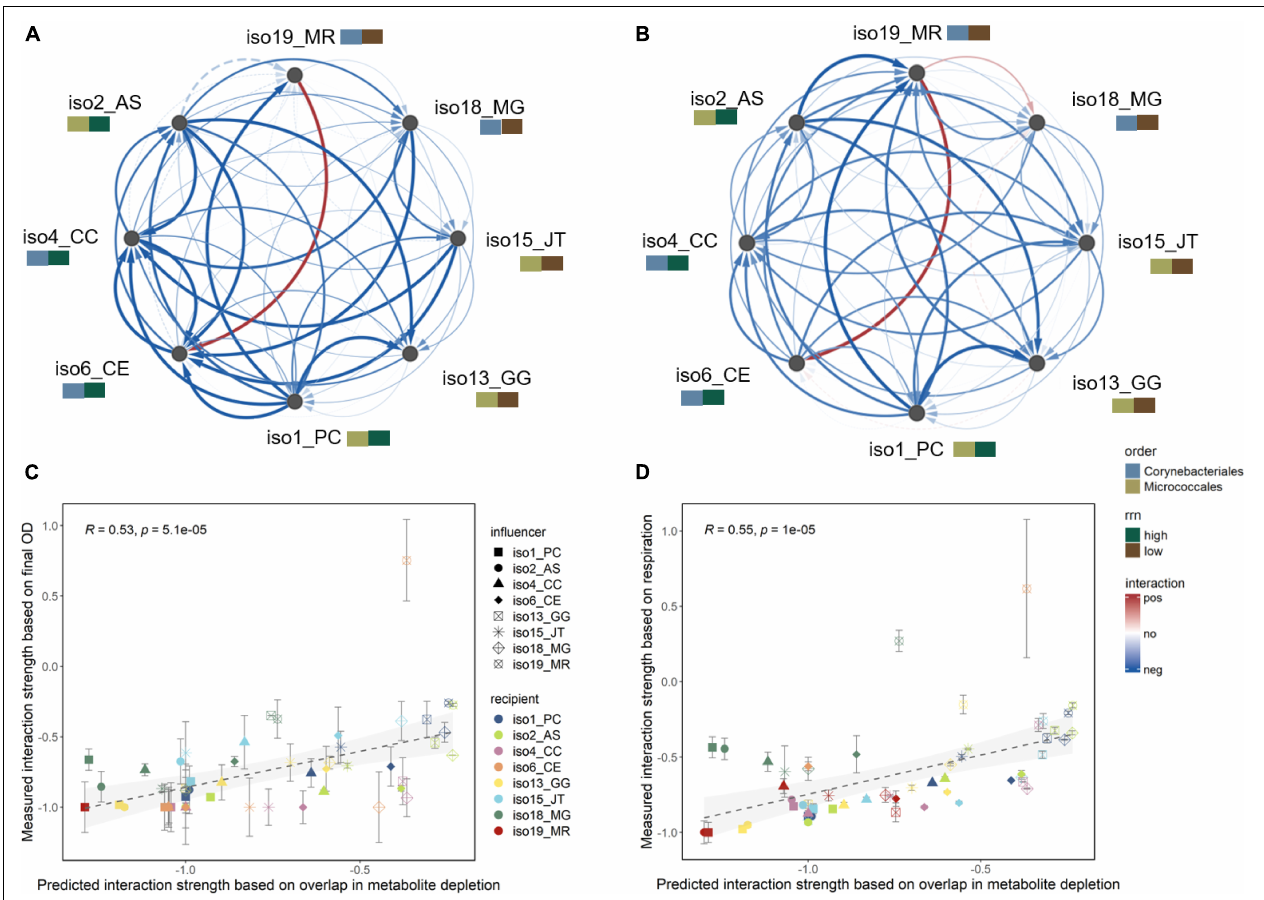
FIGURE 4 | Directional pairwise interaction strengths. Measured interaction strengths from sequential growth experiments based on (A) final OD and (B) cumulative CO 2 respiration results, shown as directed networks visualized in Cytoscape. Isolates are annotated by their phylogenetic order and order-specific rrn groups. Edge width and color correspond to mean relative fold change of the growth of recipient isolate (target node) in the spent medium of influencer isolate (source node) as compared with soil defined medium ( n = 3). Red or blue represents increased or decreased growth, indicating positive or negative interaction, respectively. Insignificant interactions ( p > 0.05, one-way ANOVA with post hoc Dunnett’s test) are shown in dashed edges. Results of individual replicates and correlation between the two interaction measures are shown in Supplementary Figure 4 . Linear correlations between the predicted ( Figure 3E ) and measured significant interaction strengths based on (C) final OD and (D) cumulative respiration. Error bars represent standard deviations ( n = 3). Correlation results for each individual recipient isolate are shown in Supplementary Figures 6,7